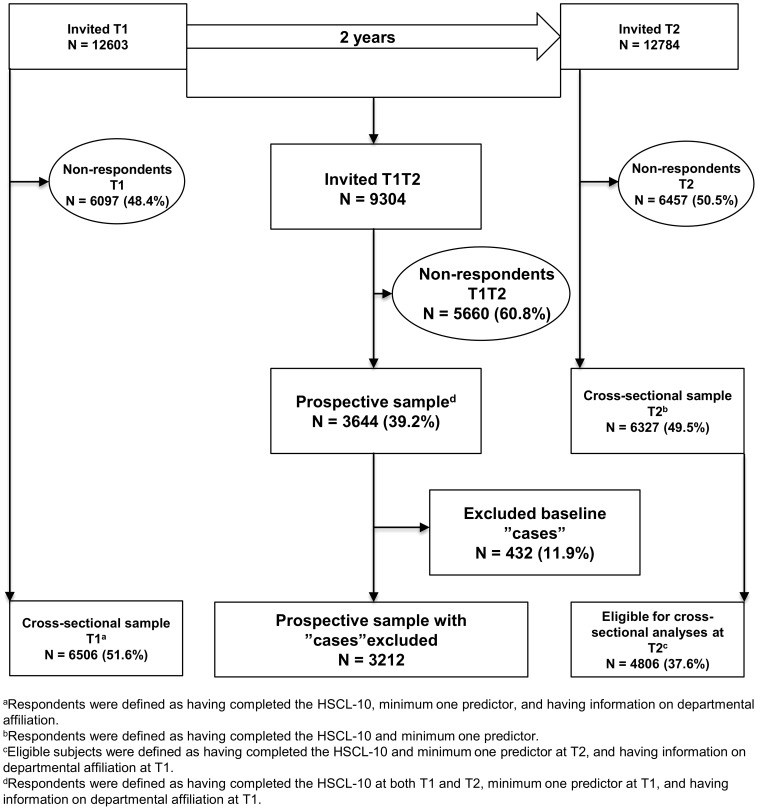
Study design and response rates.